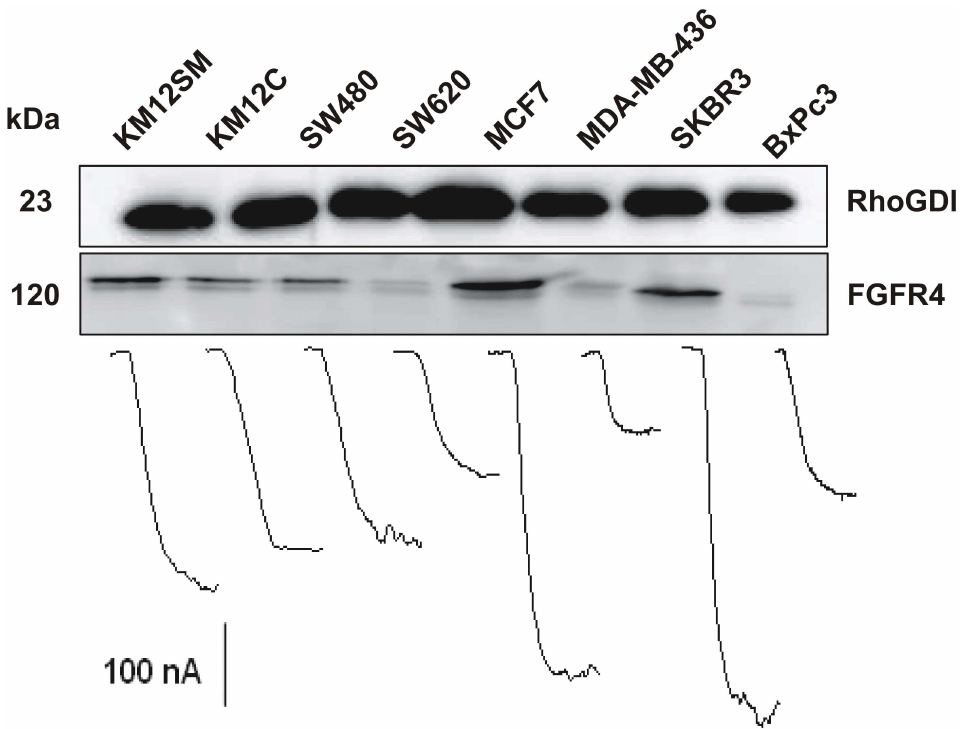
Fig 5. Analysis of FGFR4 in cell lysates by Western Blot (10 μ g) and amperometric tracesrecorded with the developed immunosensor (2.5 μ g).